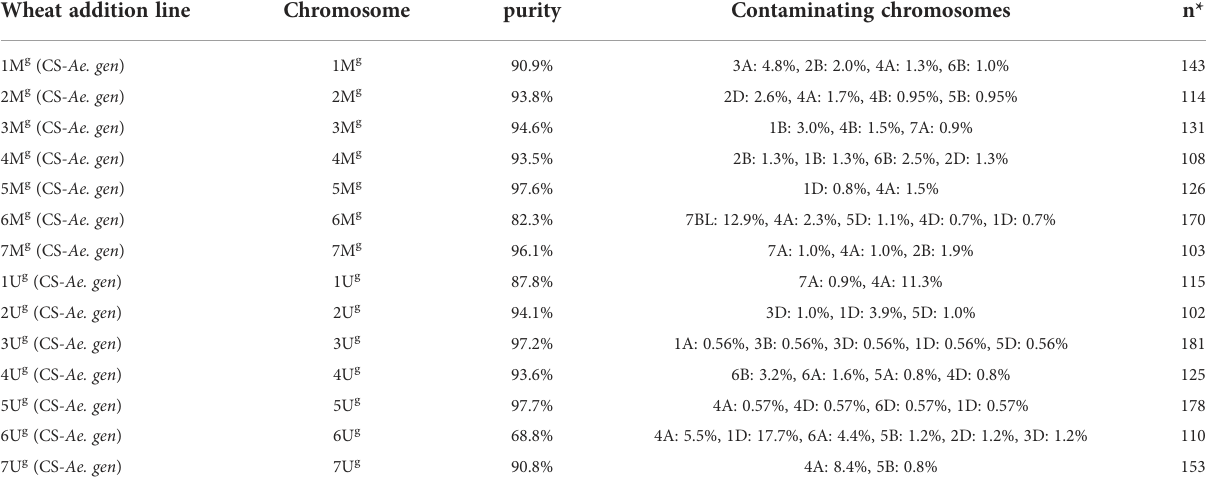
TABLE 2 Purity of M g and U g chromosomes fl ow sorted from CS- Ae. geniculata acc. TA2899 disomic addition lines. Wheat addition line